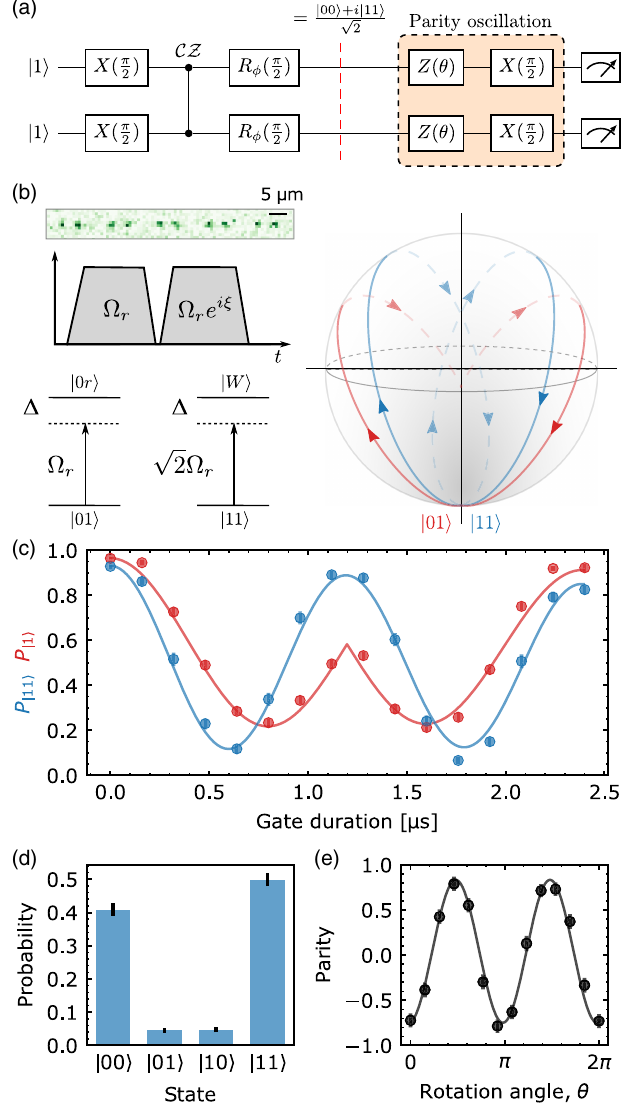
FIG. 4. Two-qubit gate. (a) Circuit diagram of the two-qubit gate characterization experiment. (b) Single-shot image of atom pairs created using rearrangement. The gate consists of two Rydberg pulses, with a phase shift on the second pulse. The level diagrams and Bloch sphere trajectories indicate the dynamics for the computational states j 01 i (red) and j 11 i (blue). (c) Evolution of the states j 1 i (blue, used as a proxy for j 01 i ) and j 11 i (red) state during the gate. The solid lines are simulations using the master equation with a phenomenological dephasing contribu- tion. (d) Measured state populations at the circuit location indicated by the red dashed line. (e) Parity oscillations, with contrast C ¼ 0 . 79 ð 3 Þ . In all panels, the error bars show (cid:3) 1 σ statistical ≈ 0 . 377 , ξ ≈ 3 . 902 , and τ Ω ≈ 4 . 293 , ϕ For Δ = Ω 11 ¼ r r 2 ϕ π , realizing a CZ gate [7]. 01 þ